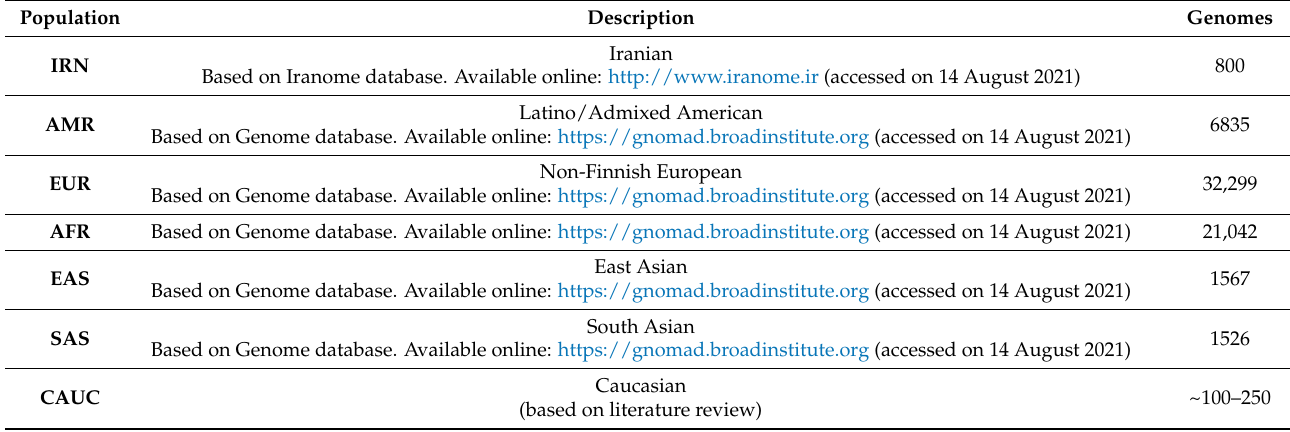
Table 1. Number of Genomes sequenced in Iranian population compared to 5 major populations and Caucasians. Population Description